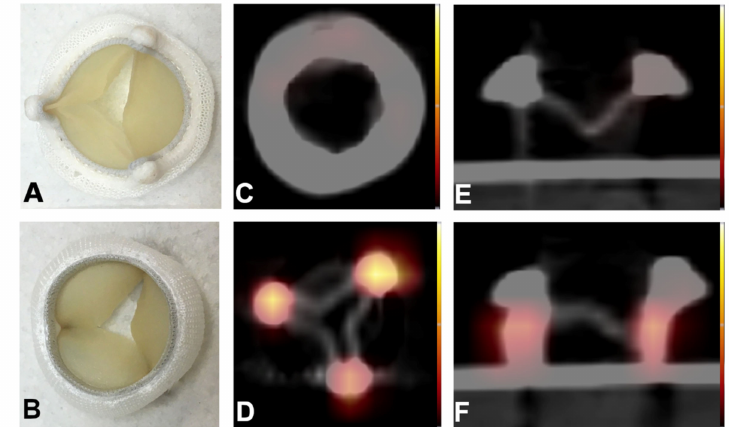
Figure 4. Unused bioprosthesis. ( A ) Bottom view of bioprosthesis, ( B ) Top view of bioprosthesis, ( C ) Bottom aspect of fused PET/CT—no accumulation, ( D ) Top view of fused PET/CT showing tracer accumulation on stent posts, ( E ) Lateral view of bioprosthesis (center) showing no tracer accumulation on leaflets (fused PET/CT), ( F ) Lateral view of bioprosthesis showing tracer accumulation on stent posts (fused PET/CT). Color bars representing activity concentrations from 4–511